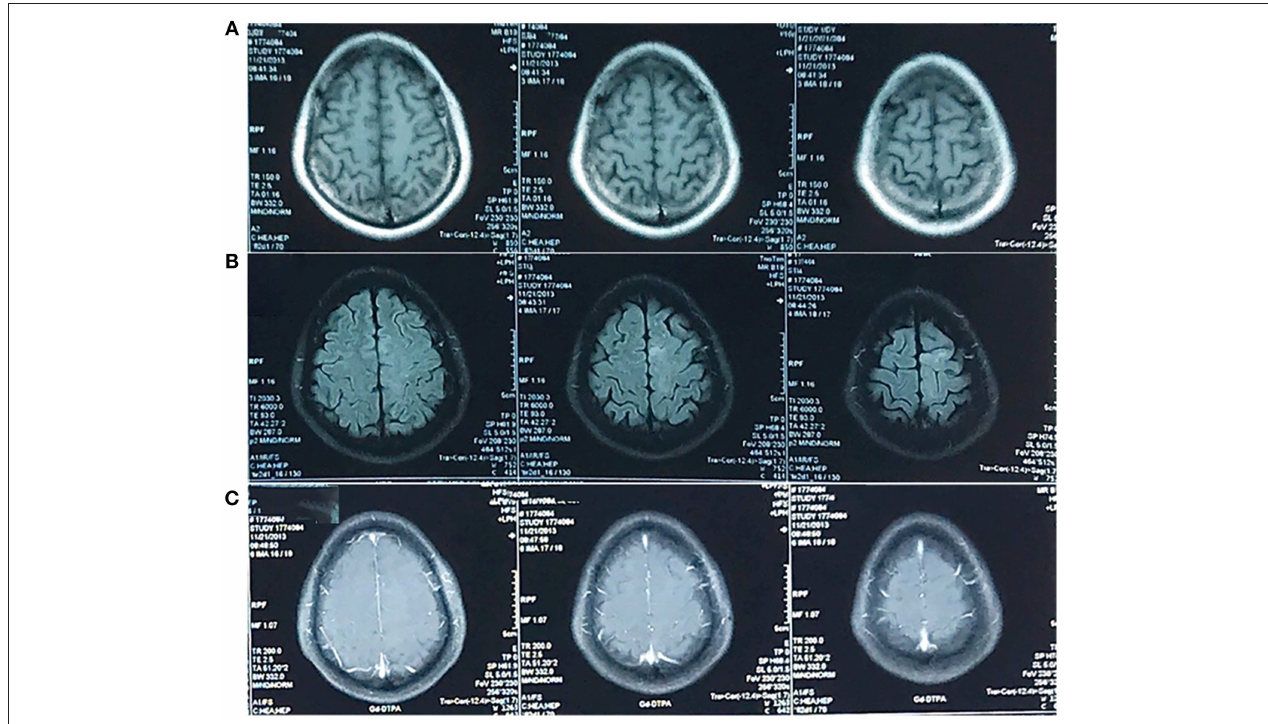
FIGURE 1 | MRI in November 2013. An abnormal signal was confined to left frontal lobe. It was not obvious on the T1-weighted image (A) and hyperintense on the T2-weighted-Fluid-Attenuated Inversion Recovery (T2-FLAIR) image (B) in the absence of enhancement (C) . The T2-weighted image was